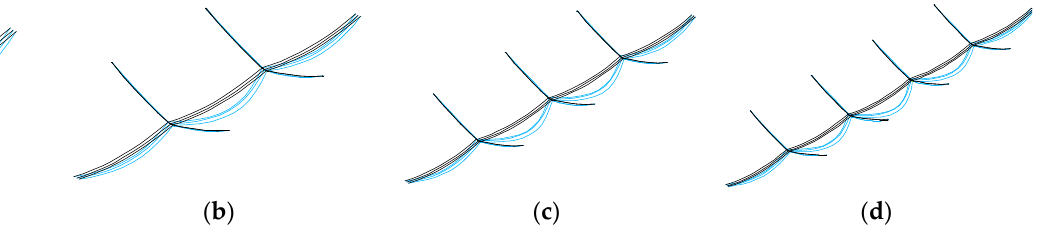
Figure 8. First asymmetric vertical bending modes of multi-span CRS. ( a ) Two spans, ( b ) 3 spans, ( c ) 4 spans, ( d ) 5 spans.